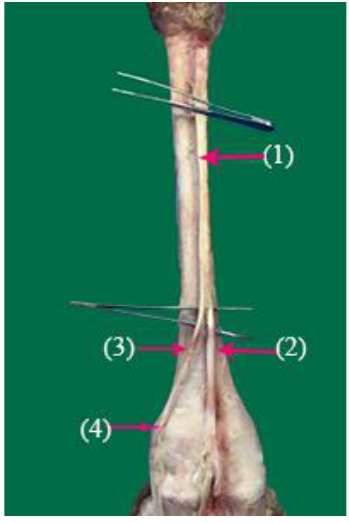
Figure 1. Nerve supply of the dorsal surface of the distal hindlimb in camels: (1) superficial fibular nerve; (2) common dorsal digital nerve of the third digit; (3) common dorsal digital nerve of the fourth digit; (4) abaxial dorsal proper digital IV nerve.